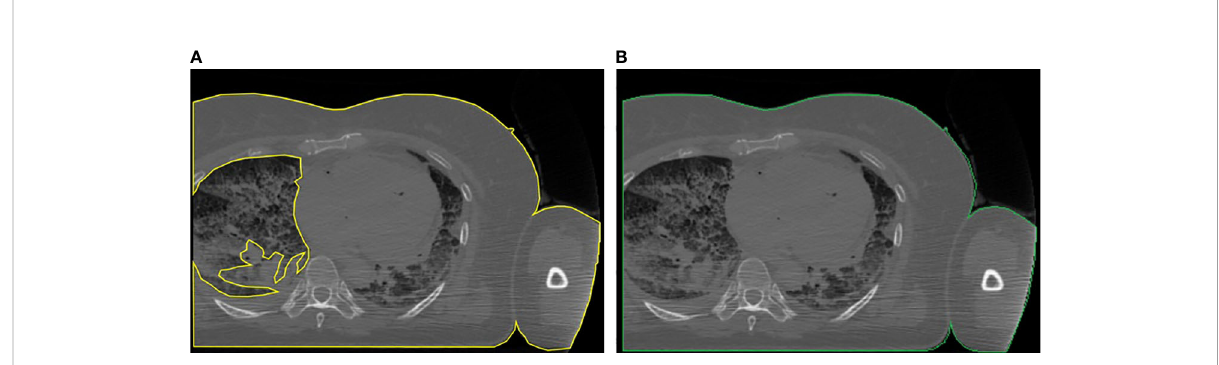
FIGURE 2 Example of the correction applied to truncated images: (A) body region not properly located and (B) body region after the